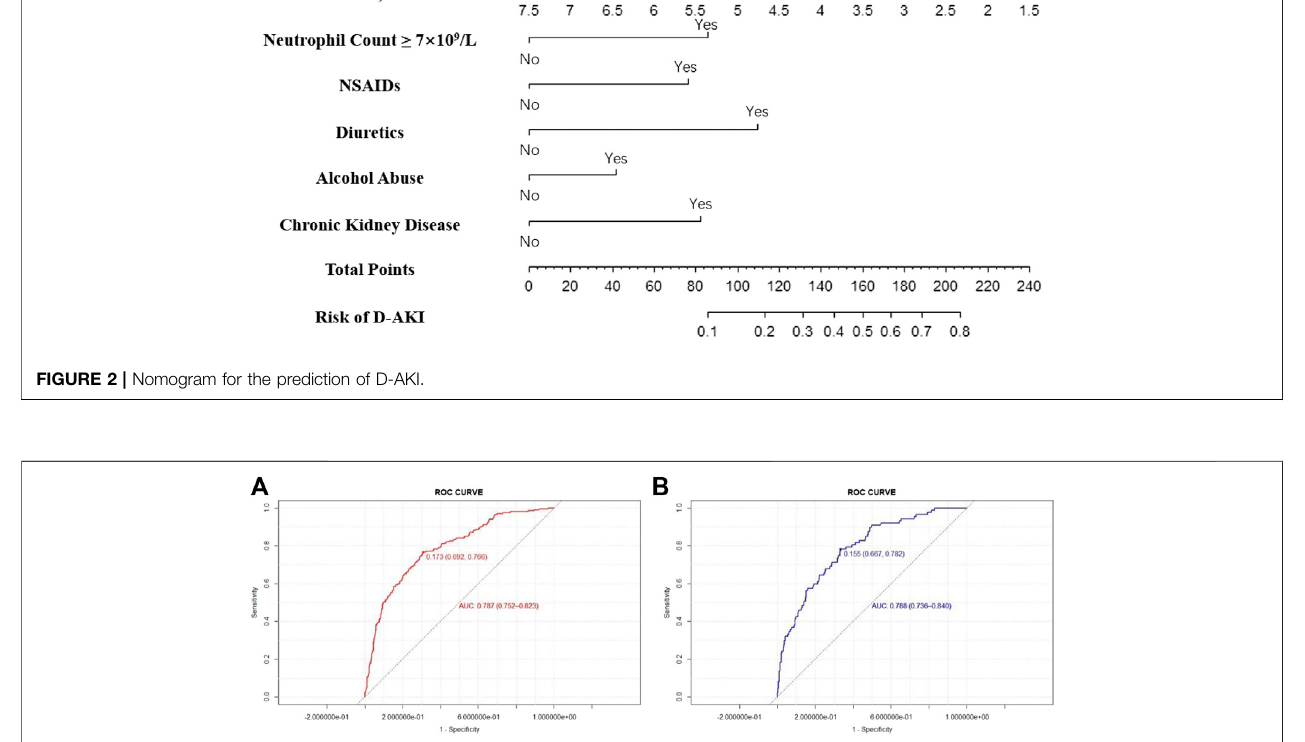
FIGURE 3 | The ROC curve in the development (A) and validation (B)